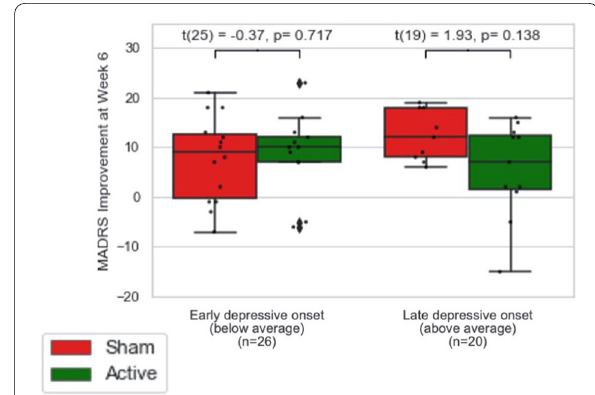
Fig. 3 Variables interacting with MADRS improvements in per-protocol analysis. MADRS Montgomery–Åsberg Depression Rating Scale. Onset * group interaction: β 0.04), p 0.04 =